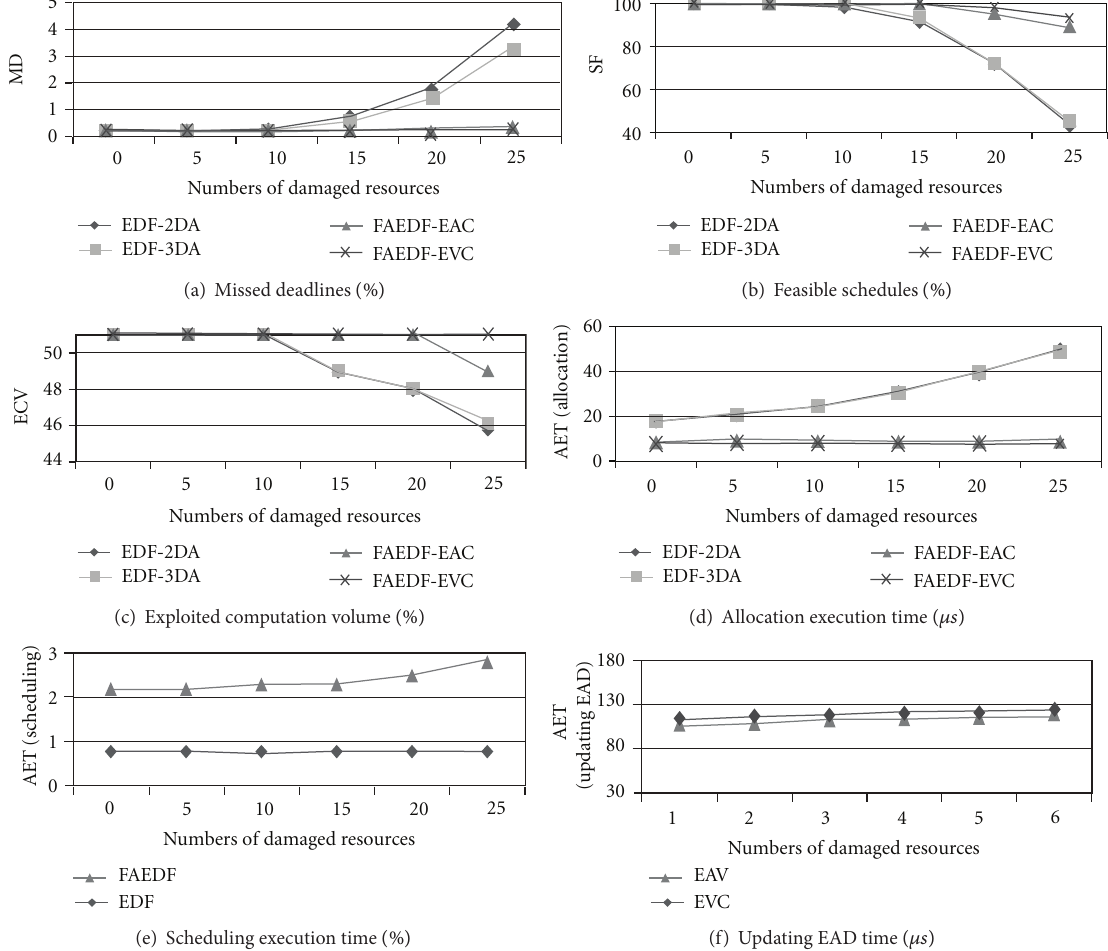
Figure 15: Medium utilization of the FPGA and moderate real-time requirements: 𝑈